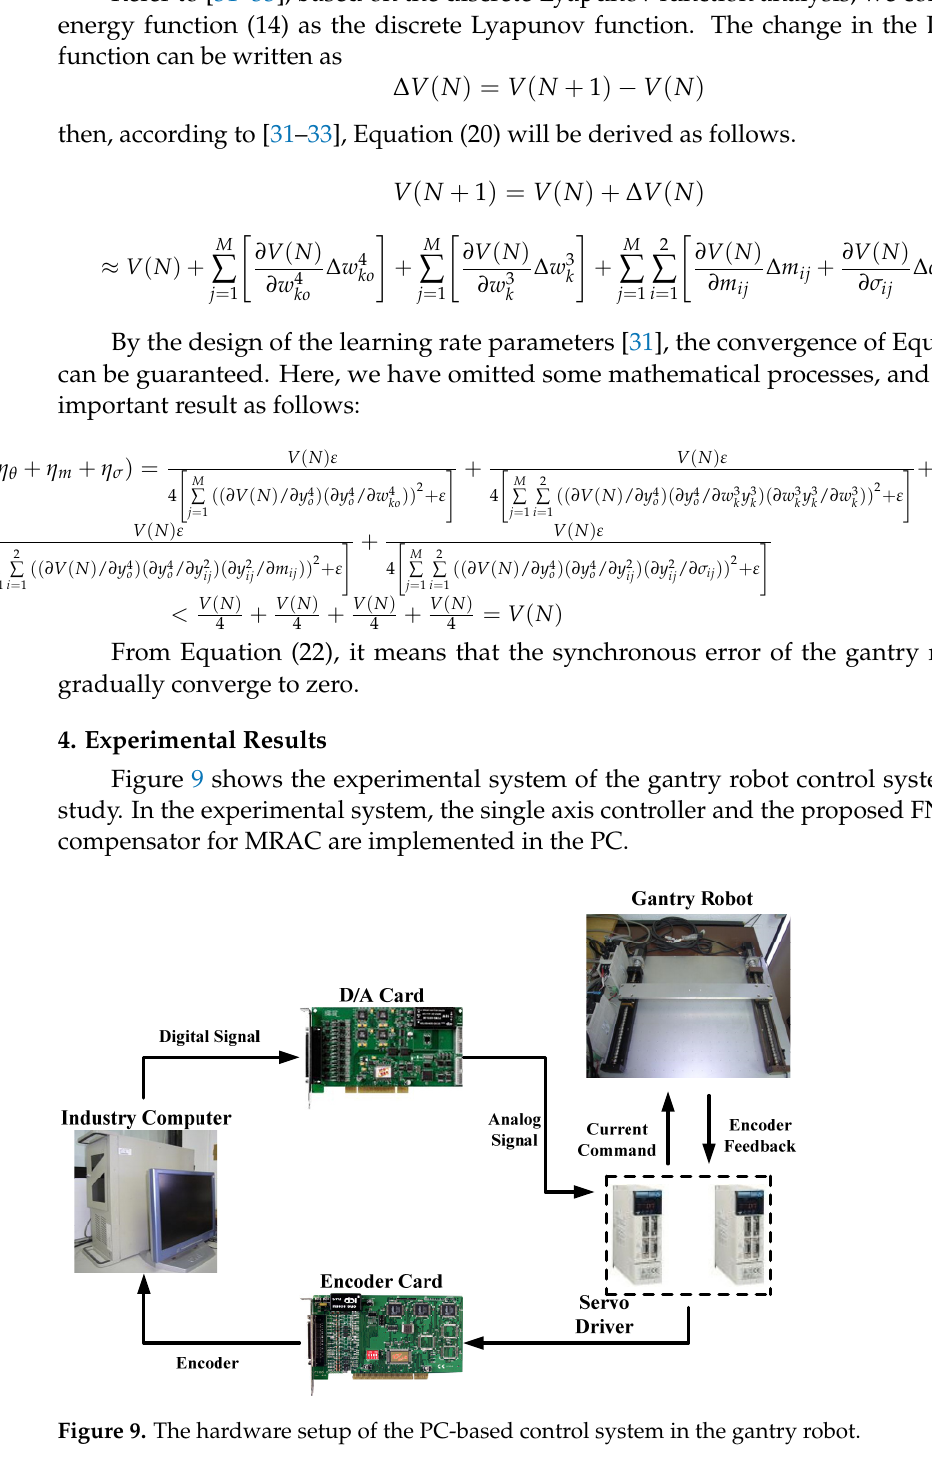
Figure 9. The hardware setup of the PC-based control system in the gantry robot.